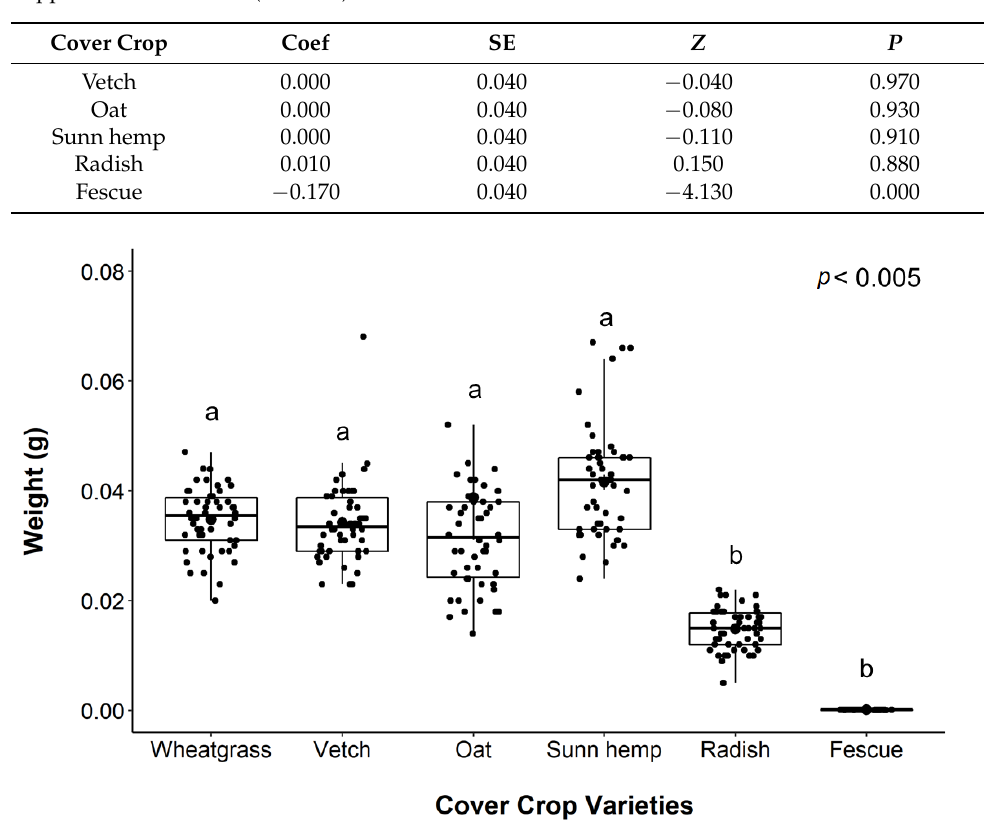
Table 2. Summary of the fitted Cox proportional hazards model for cover crop seed preferences. Coef indicates variable coefficients, SE indicates the standard error, Z is the test statistic used, and P indicates the significant values. Model output for month and temperature can be found in the Supplemental Materials (Table S1).